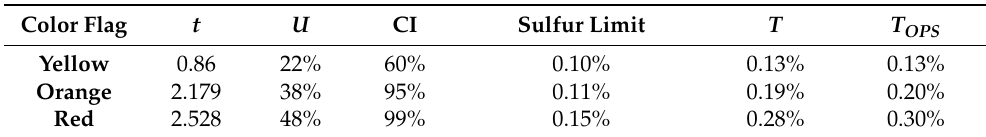
Table 2. Updated flag thresholds as of